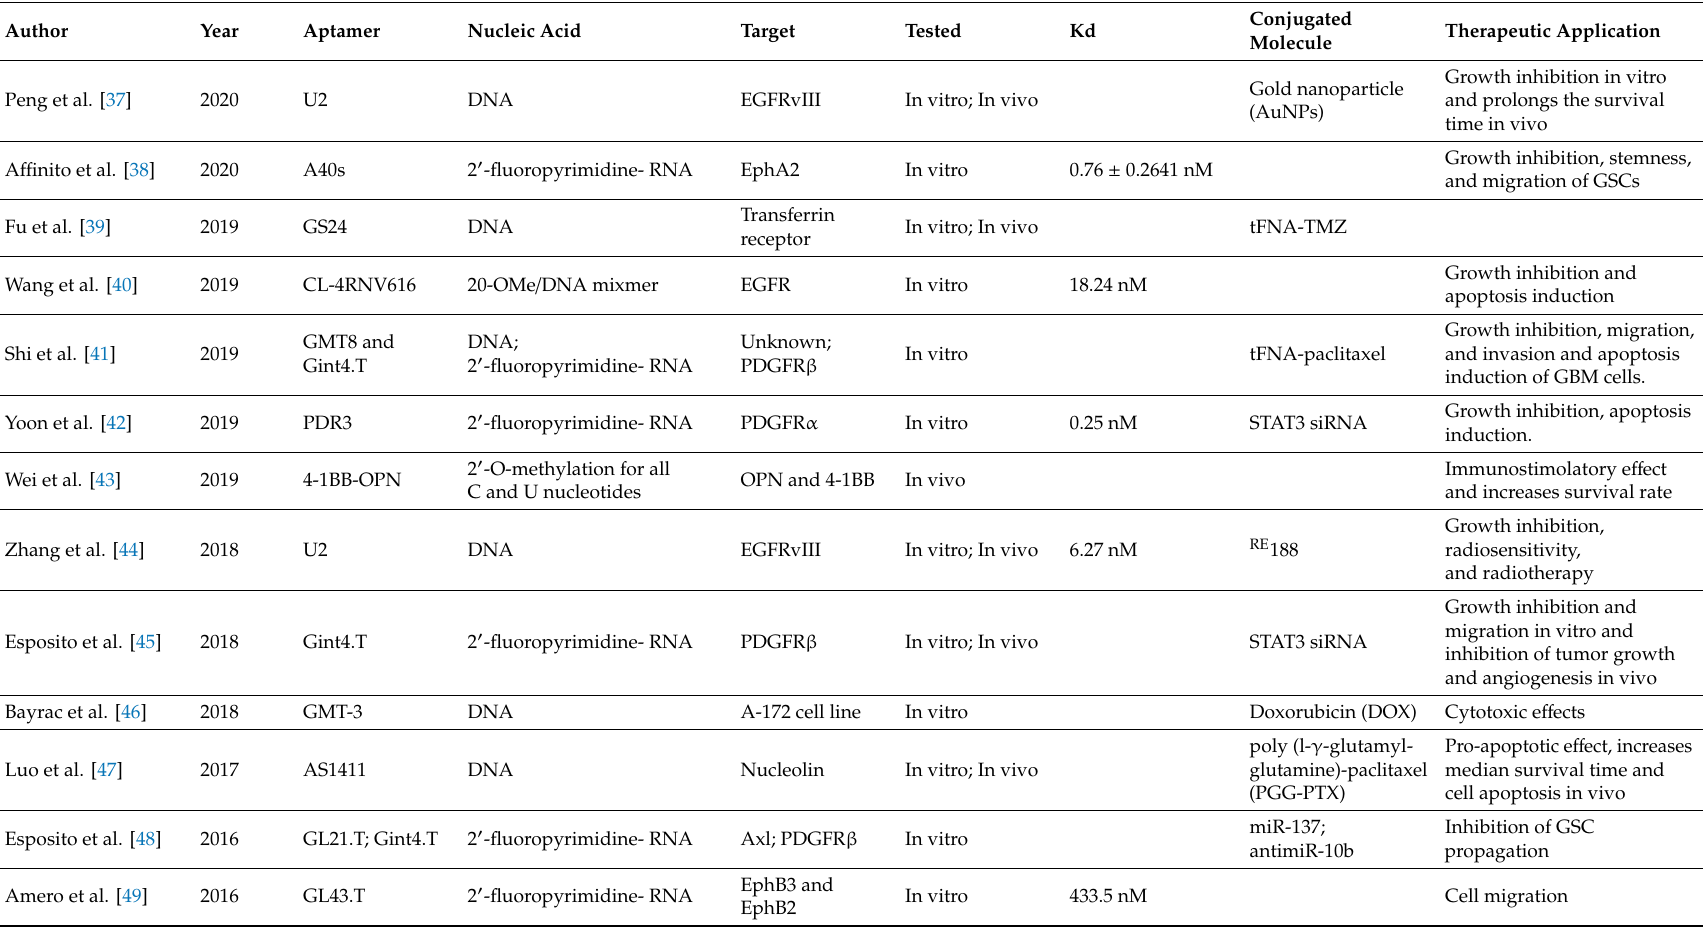
Table 2. Characteristics of included studies on therapeutic applications of aptamers in GBM. Kd = dissociation